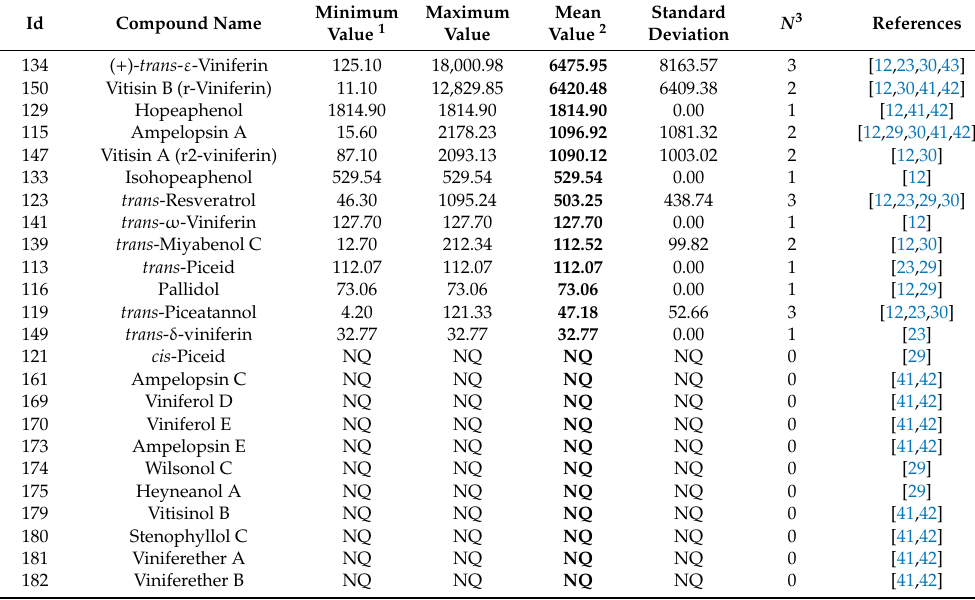
Table 10. Levels (mg / kg) of 24 stilbenic compounds identified in grapevine